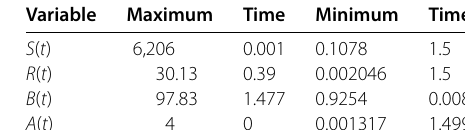
Table 7 Extremum values of the realizations Variable